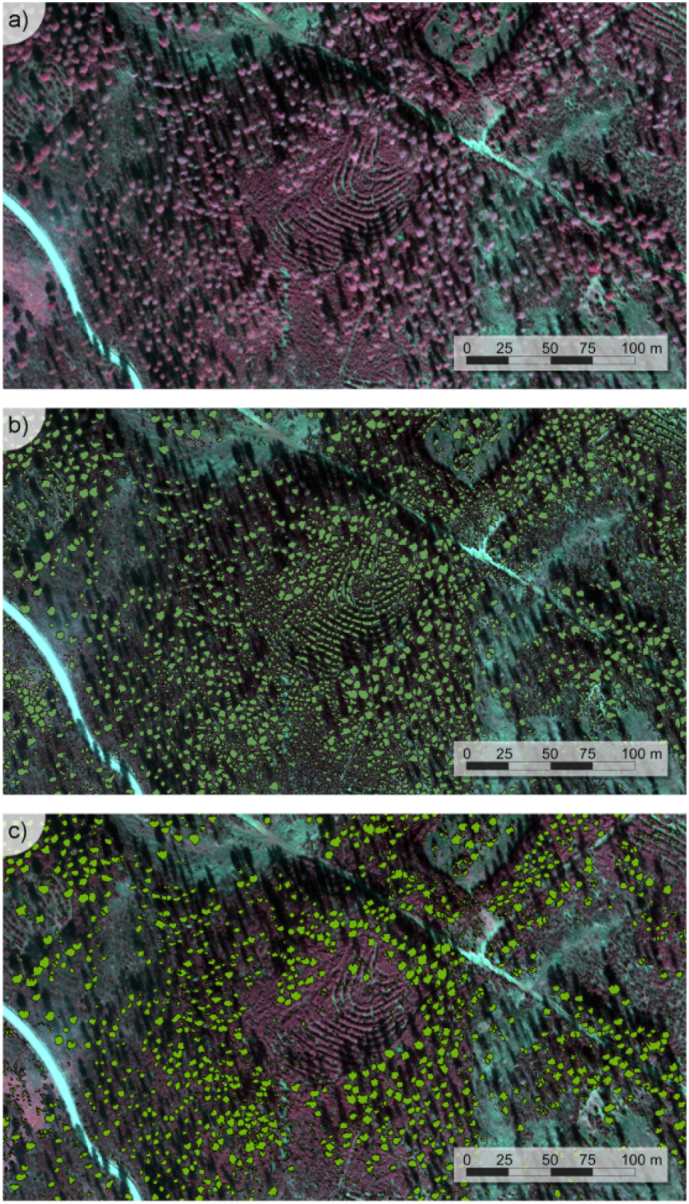
Image segmentation results separating crowns and understory from the shadow and sunlit soil components, showing the original hyperspectral image (a), the segmentation of the tree crowns and understory (b), and the selection of pure tree crowns without the understory component (c).